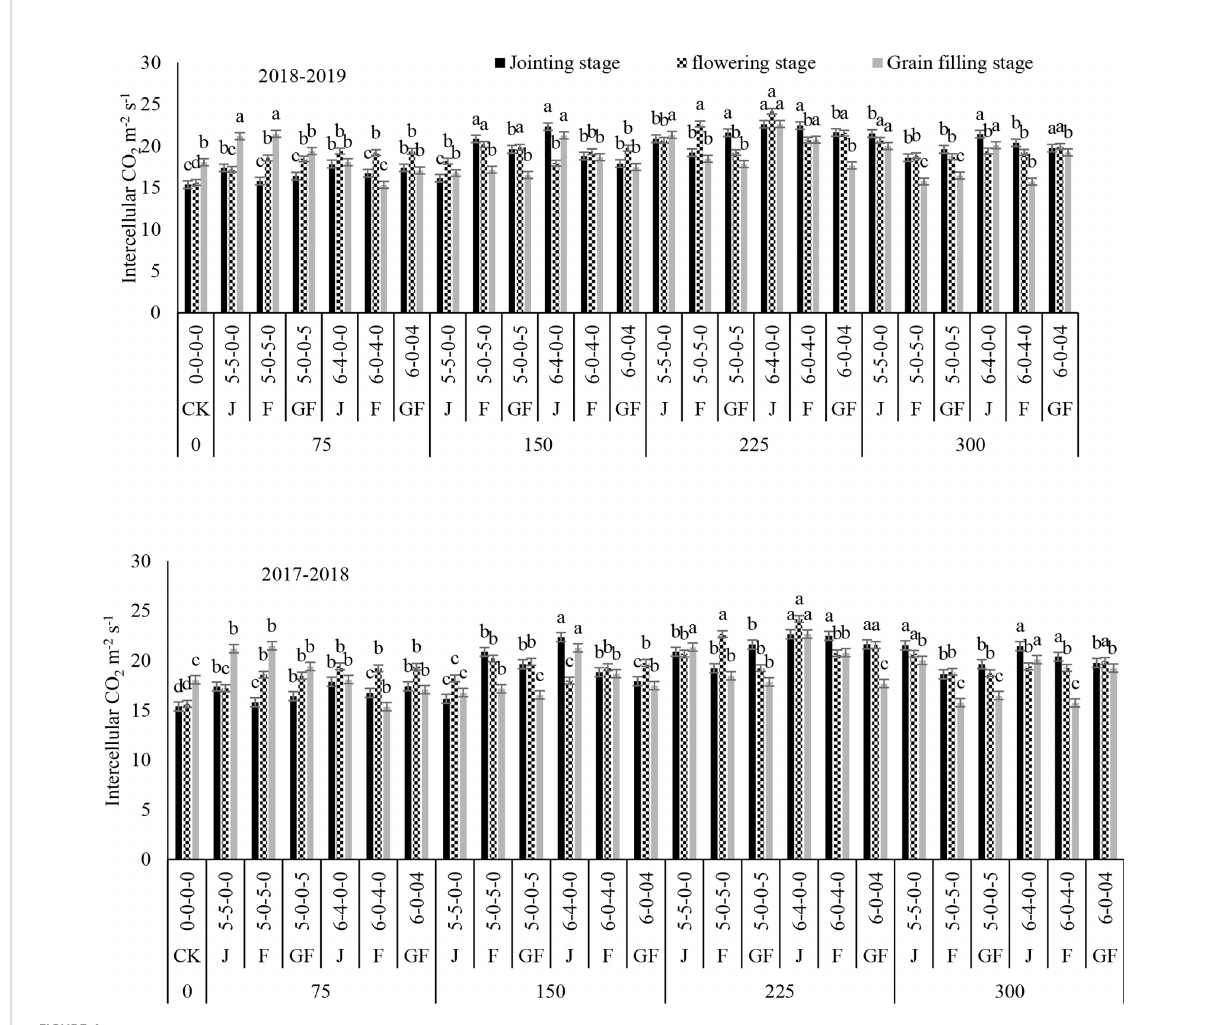
FIGURE 4 Effect of nitrogen fertilizer management on the intercellular CO 2 concentration of winter wheat. JS , jointing stage; FS , fl owering stage; GF , grain fi lling stage. Different letters in above bars indicate a signi fi cant difference